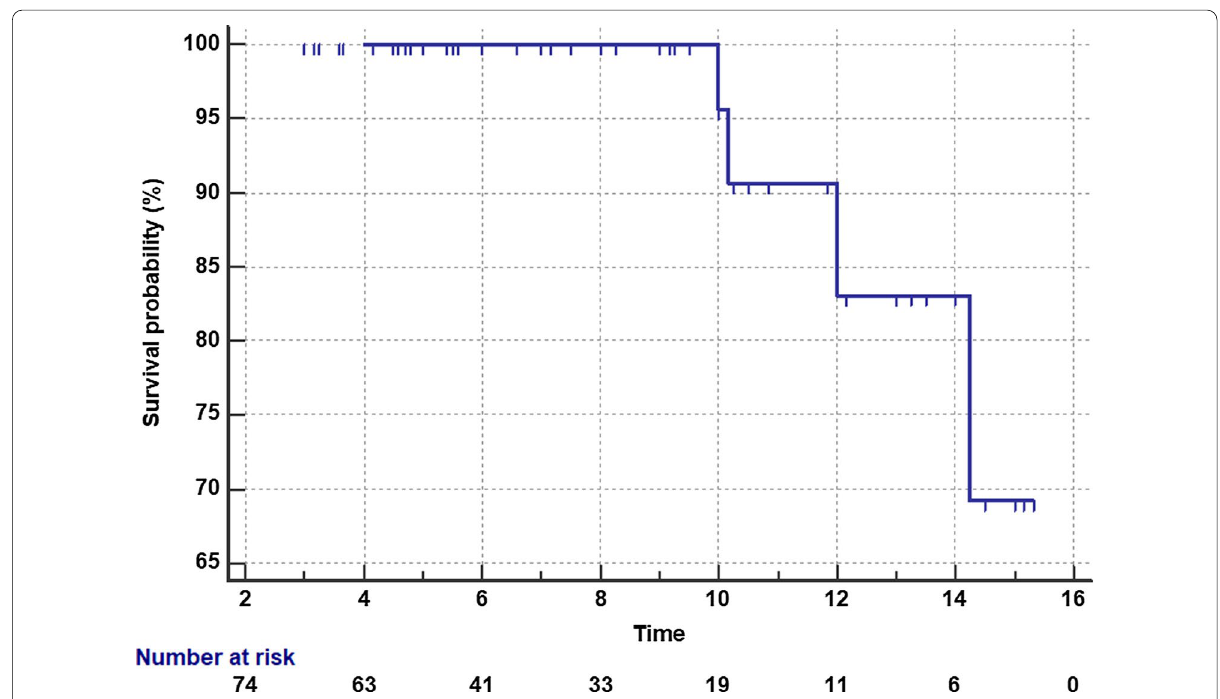
Fig. 9 Kaplan–Meier (K–M) survival plot. The K–M estimator analysis showed an overall survival rate at 10 years of 95